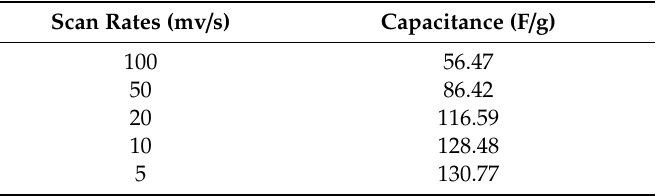
Table 5. Capacitance values from cyclic voltammetry (CV) against scan